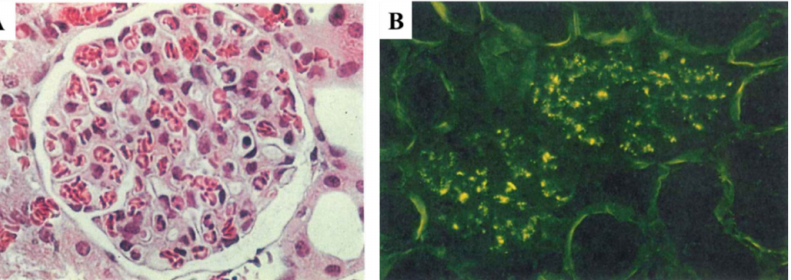
Figure 14. ( A ): Representative light microscopy image of experimental glomerulonephritis induced by the administration of streptococcal nephritogenic protein in rabbits, 4 weeks after the start of injection. Moderate endothelial and mesangial proliferative changes with prominent infiltrating leu- cocytes are evident (H&E, original magnification × 400). ( B ): Immunofluorescence of glomeruli from representative rabbits in experiment, 4 weeks after the start of injections. C3 is intensely deposited along the glomerular basement membrane and mesangial areas (FITC-labelled goat anti-rabbit C3, original magnification × 200). Photographs are cited from a previously published report [45], where details of all the staining methods have been